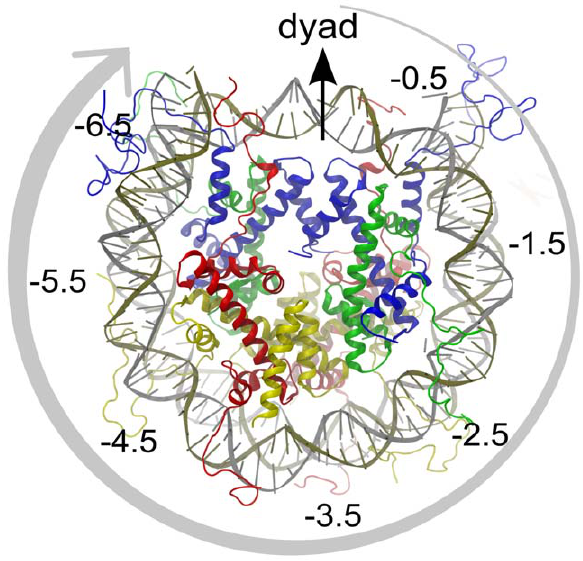
Figure 1. Architecture of the nucleosome core particle (PDB ID 1KX5; [ 2 ] ). The four histone dimers H3, H4, H2A and H2B are colored in blue, green, red and yellow, respectively. The four histone dimers are arranged about a twofold dyad symmetry axis, which also intersects the middle of the DNA fragment. DNA positions around the nucleosome are described by super helical locations, or SHLs, numbered here. The middle of the DNA fragment at the dyad position is referred to as SHL0. Starting from the dyad along the outer wrap of DNA on the nucleosome (shown by an arrow in the figure), each minor groove facing the histone core is denoted by SHL + 0.5, SHL + 1.5, etc. (positive in one direction, negative in the other).